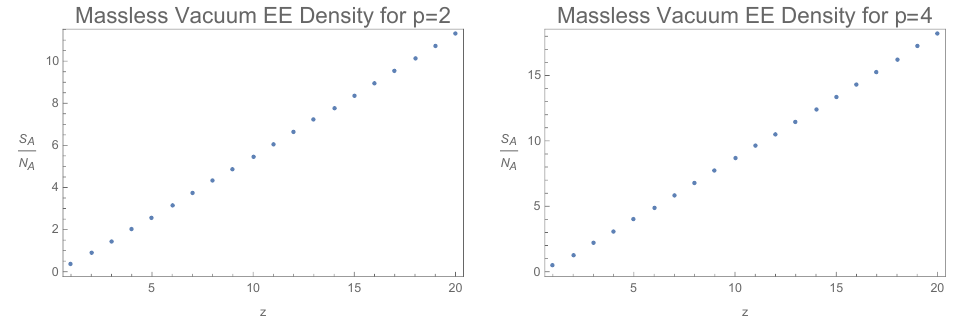
Figure 6: Vacuum EE density for p = 2 and p = 4 as a function of z . The vacuum EE density becomes a linear function of z for sufficiently large z